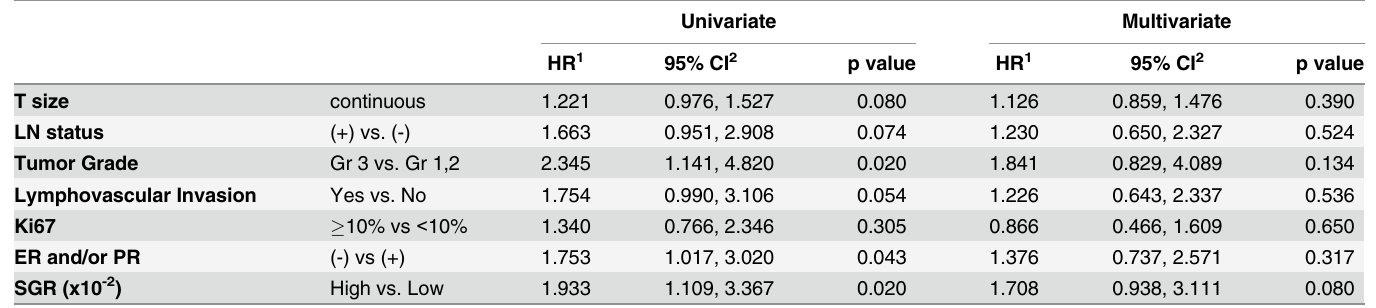
Table 3. Cox regression analysis for DFS in D 0 >